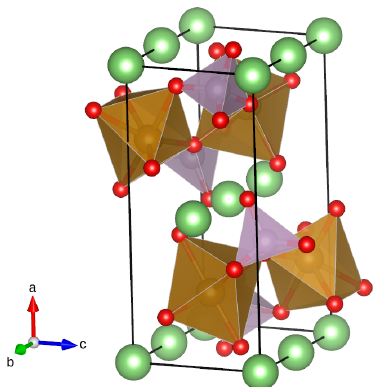
Figure 1. Olivine structure of Li M PO 4 : Li atoms are represented in green, O atoms in red, and P and Mn atoms, respectively, by distorted tetrahedra (violet) and octahedra (brown). The coordinate system is reported on the left of the structure. The picture shows that Li ions are aligned along the b -axis: the structure presents 1D channels along the b -axis that are responsible for lithium transport. Mn ions occupy 4c Wickoff positions at the center of octahedra: for the simulation of doping, one Mn ion was substituted with Ni or Co. The figure was produced using the Vesta visualization system